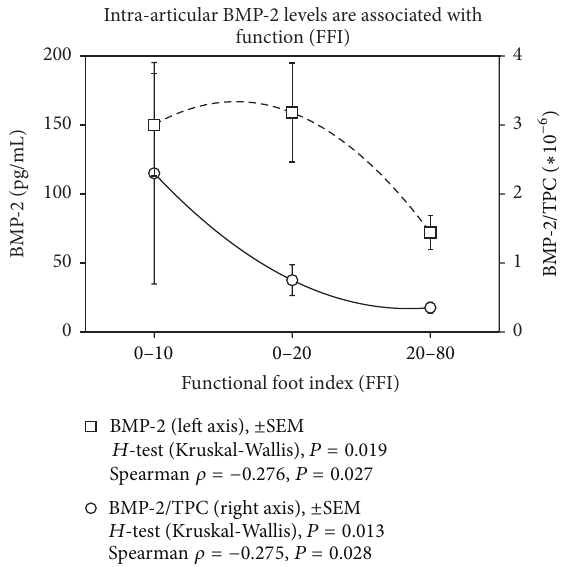
Figure 4: High levels of BMP-2 are associated with a good function (low FFI). Results of the Spearman correlation and the post hoc statistics (Kruskal-Wallis H -Test) are indicated for absolute BMP- 2 levels and concentrations in relation to the total protein content (TPC) on the bottom. Polynomial regression with degree of 2 gives an 𝑅 2 = 1 for absolute and for relative concentrations; values are shown with ±